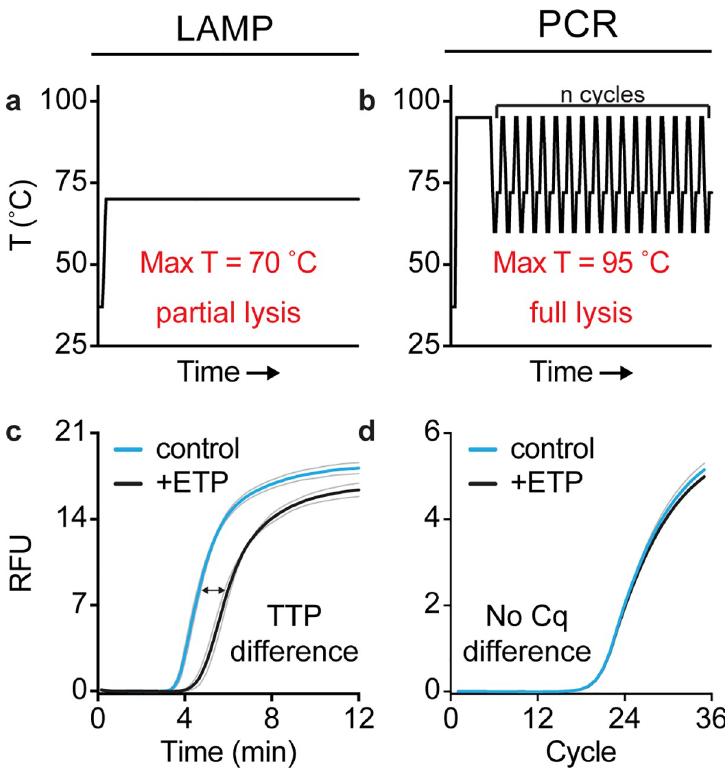
Fig 2. The pol-aAST requires non-lytic amplification conditions. (a–b) Thermal profiles of LAMP and PCR. (c–d) LAMP and PCR amplification curves for a susceptible E . coli isolate exposed to ETP for 15 min. Blue and black lines are the average of triplicate samples. Grey lines represent standard deviation of triplicates. A difference in TTP for control and treated aliquots is observed for susceptible isolates when quantifying NAs using LAMP, but not PCR. Raw data are provided in S5 Table. AST, antibiotic susceptibility test/testing; Cq, quantitation cycle; ETP, ertapenem; LAMP, loop-mediated isothermal amplification; NA, nucleic acid; PCR, polymerase chain reaction; pol-aAST, polymerase-accessibility AST; RFU, relative fluorescent units; TTP, time-to-positive.